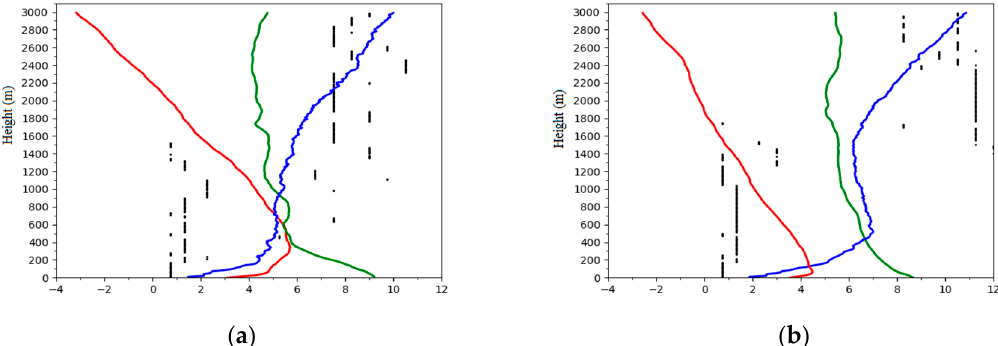
Figure 2. Averaged vertical structure of the atmosphere for ( a ) 23 seriously polluted cases, averaged VI = 2451 m 2 /s, AQI = 342 ( b ) 62 clean cases, averaged VI = 4925 m 2 /s, AQI = 72. The line and scatter plot show the profile of temperature (red line, °C), relative humidity (green line, %), wind velocity (blue line, m/s) and wind direction (black scatter points, wind direction is the dominant wind direction at each height, °) for 23 seriously polluted cases and 62 clean cases in autumn-winter seasons (2013–2015). The number on the x-axis is the result after dividing the relative humidity value by 10 and wind direction angle by 30 while temperature and wind speed remain the same.